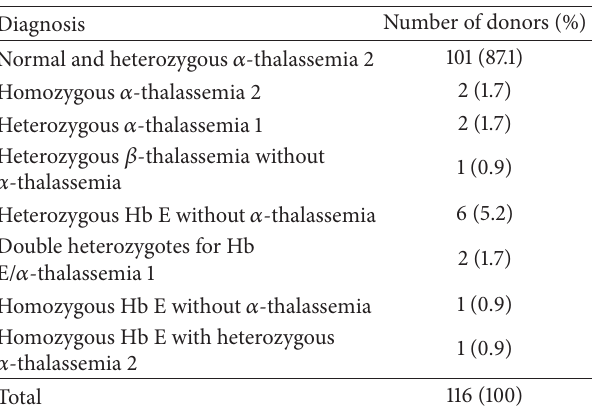
Table 2: Prevalence of thalassemia and Hb E among Southern Thai blood donors.